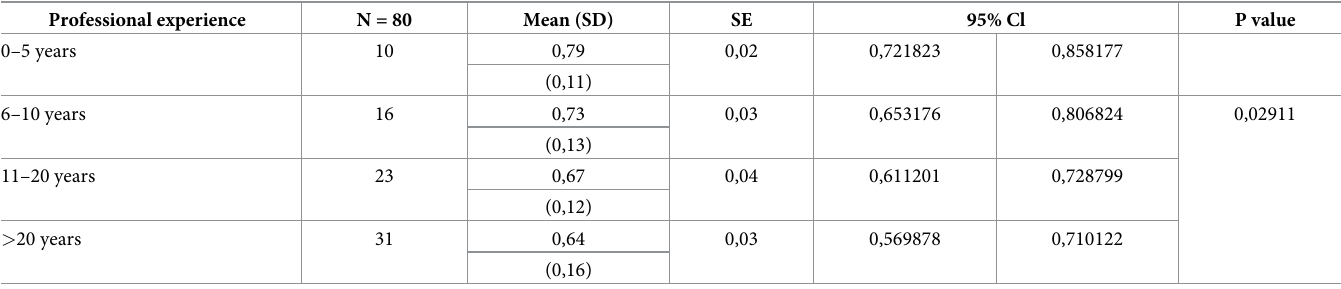
Table 1. Influence of professional experience on the training domain.